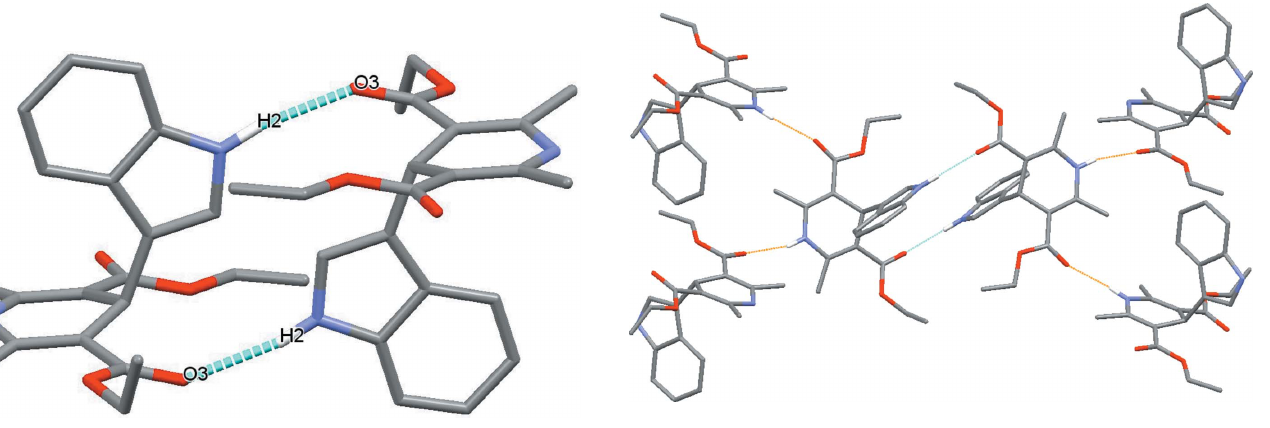
Figure 2 Part of the structure showing a dimer formed by N—H (cid:3)(cid:3)(cid:3) N hydrogen bonds (shown as blue dashed lines).